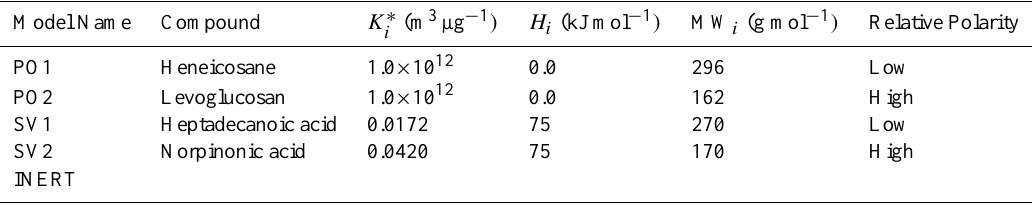
Table 2. Aerosol compound properties.